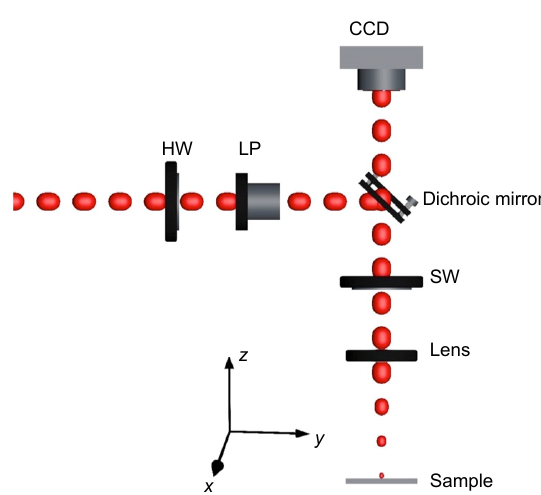
Fig. 1 | The experimental setup used for surface structuring. The laser fluence was tuned via the use of a λ /2 waveplate (HW) and a linear polarizer (LP). Laser source emits a Gaussian linearly polar- ized beam, which is transformed to a CV radially polarized beam by means of an s-waveplate (SW). Large areas were produced via translation of the sample in the x - y - z